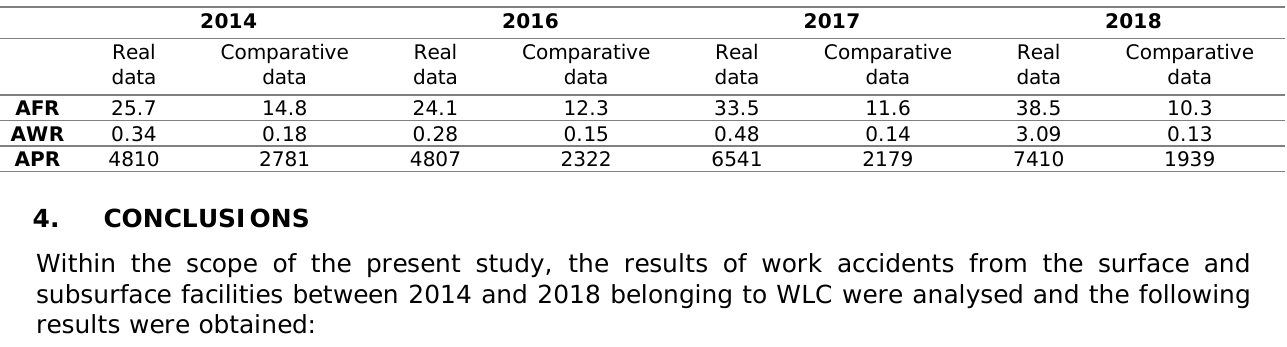
Table 4. Adjustment of DMU of